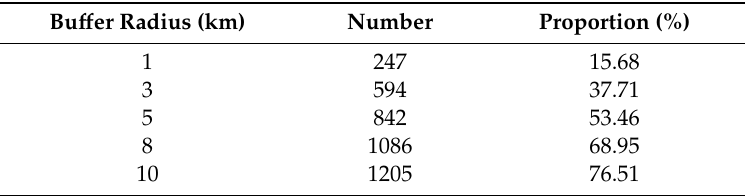
Table 4. Proportions of toponyms in the direction-related toponym dataset (DRTD) in di ff erent bu ff ers. Bu ff er Radius (km)